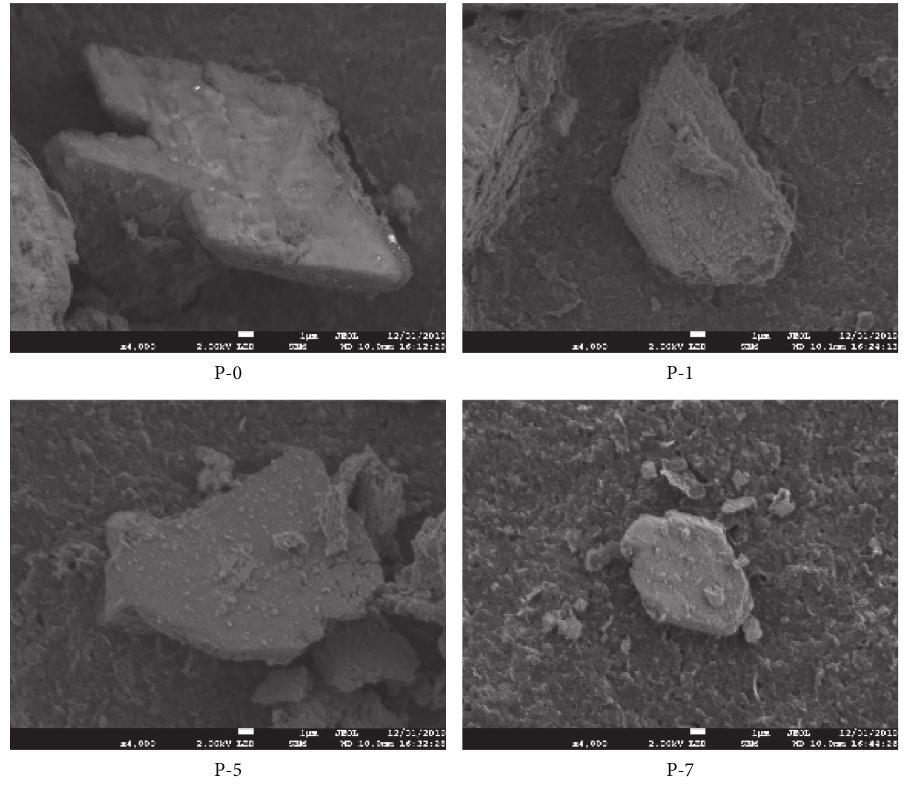
Figure 11: Particle morphology (4000 ×